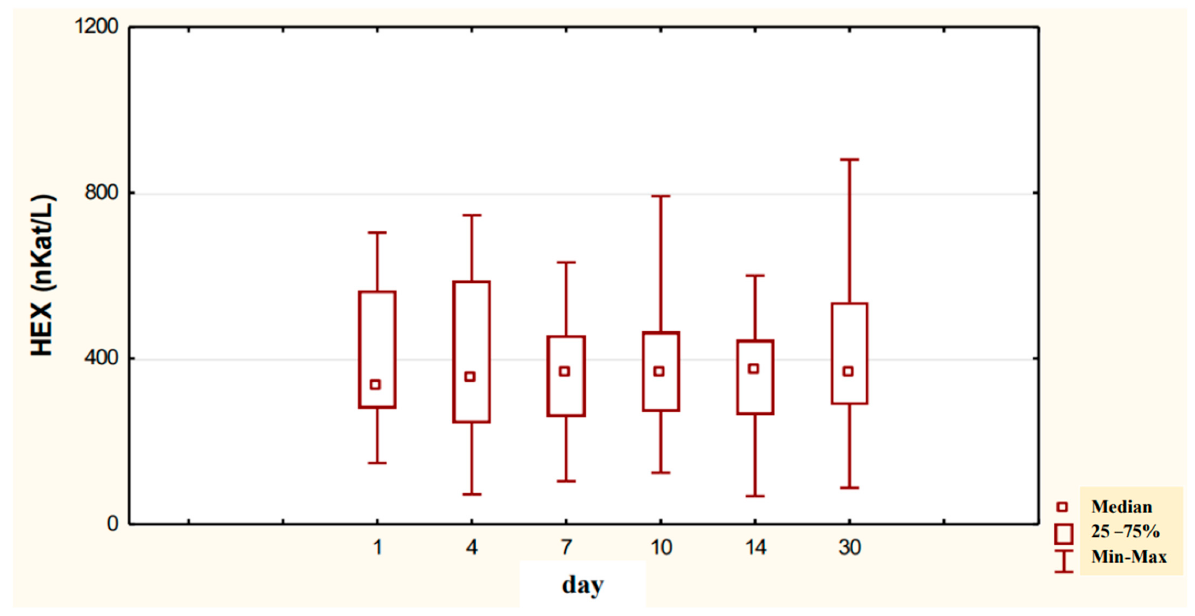
Figure 2. Variability over time in the concentration of serum HEX activity (nKat/L) of alcohol-dependent patients treated with neoglandin (N).